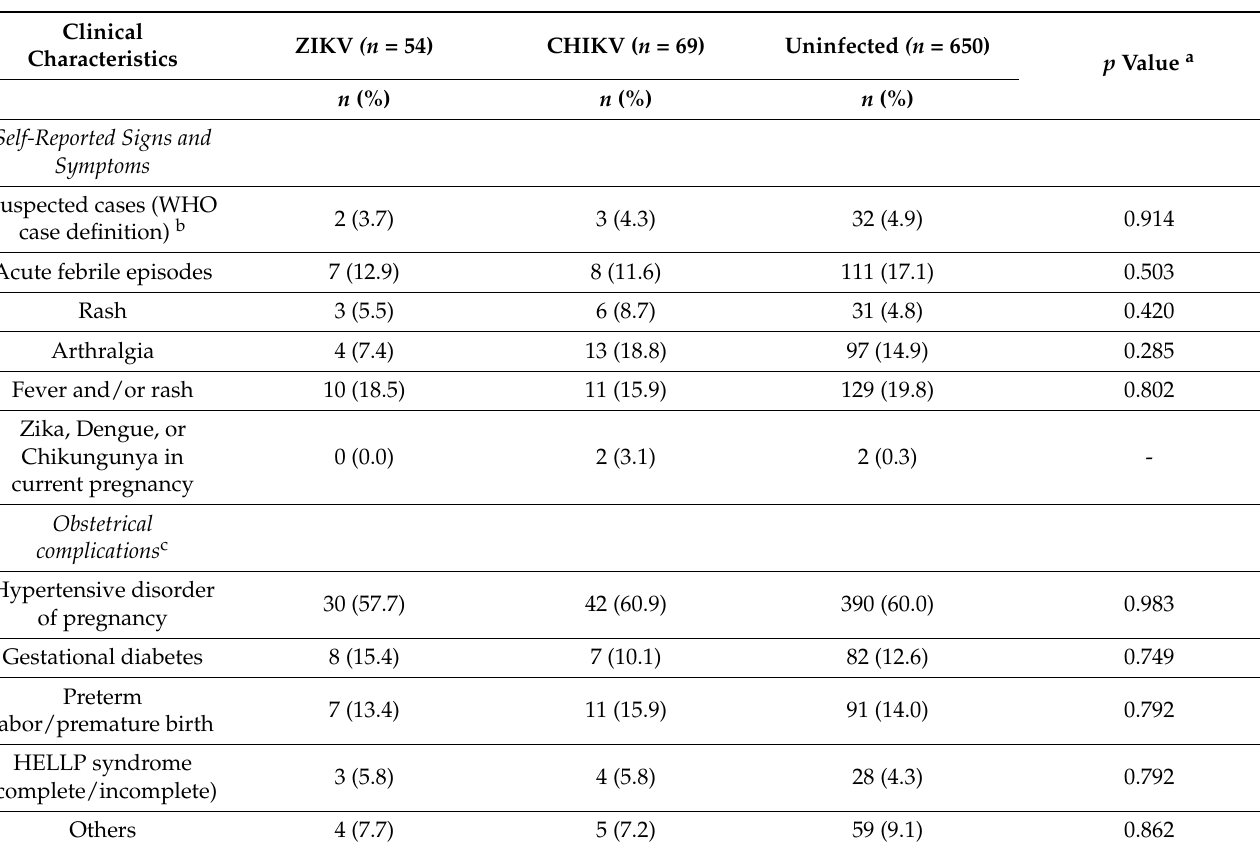
Table 3. Characteristics of pregnant women with active/recent ZIKV or CHIKV infection and those uninfected according to the reported symptoms and obstetric complications in a high-risk maternity hospital in Northeastern Brazil.